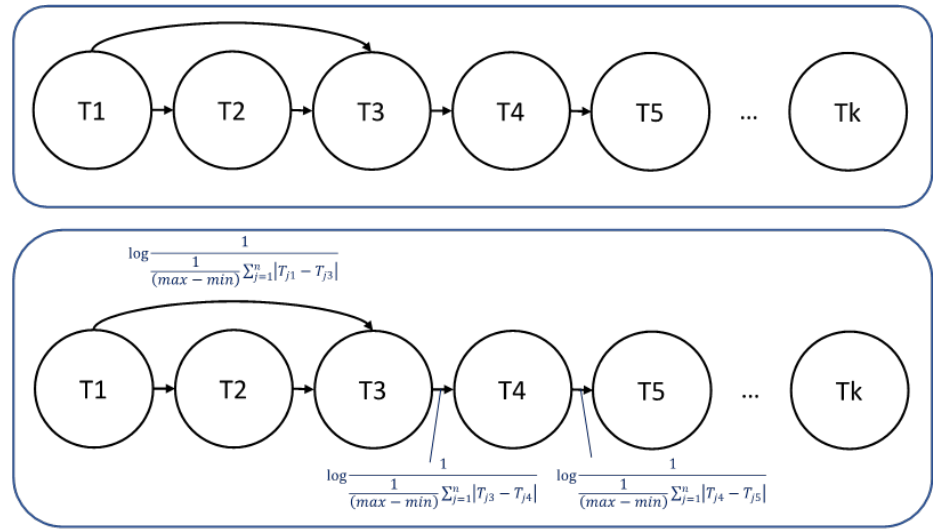
Figure 1. A directed graph representation based on the test administration